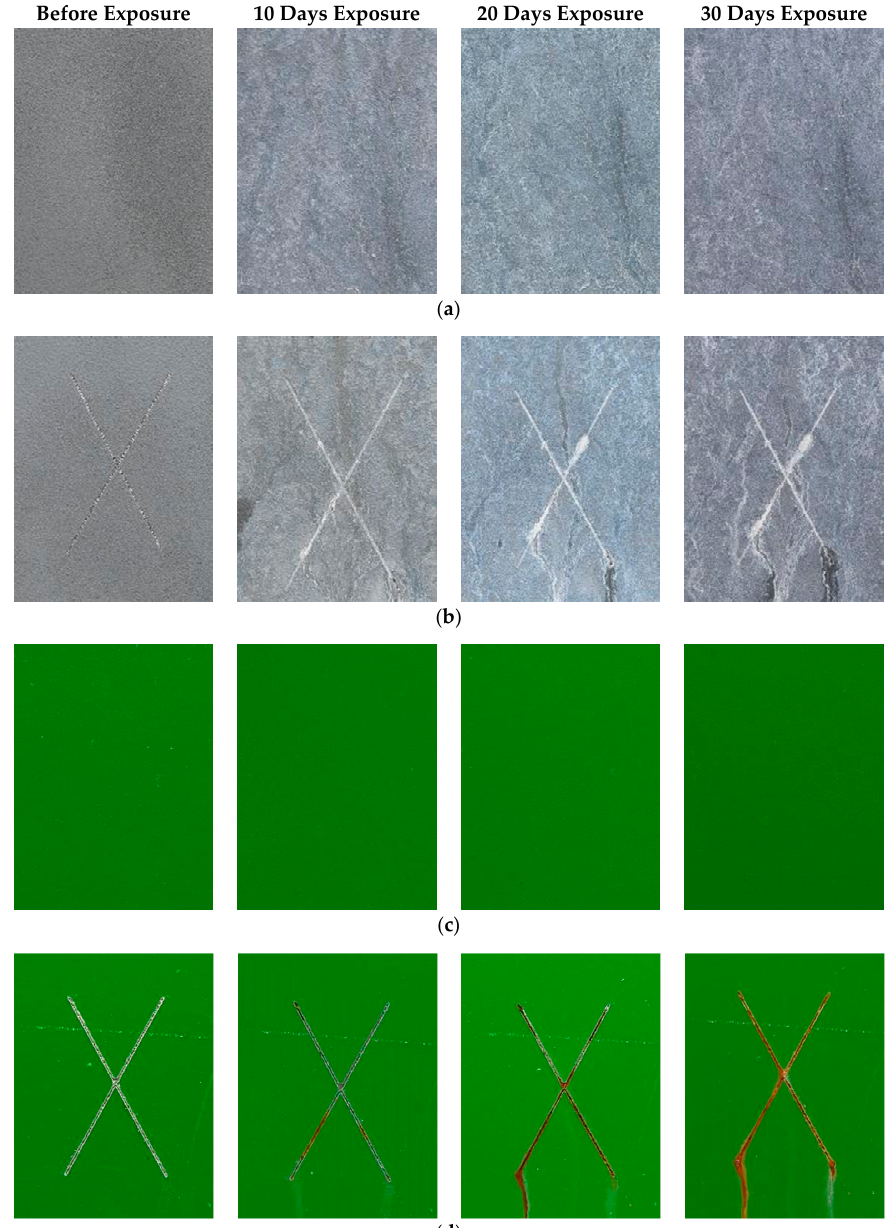
Figure 1. Appearance of coating systems after accelerated exposure corrosion test of ( a , b ) Commercial 80 µ m zinc rich primer and ( c , d ) Commercial three-coat system (80 µ m zinc rich primer, 100 µ m intermediate layer, 50 µ m top coat). ( a , c ) non-scribe; ( b , d )